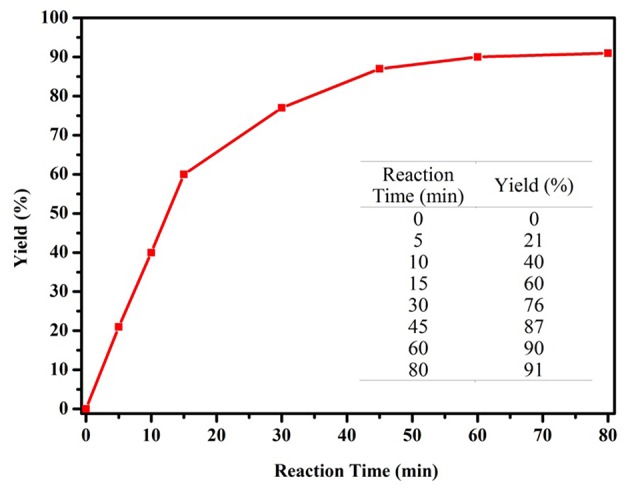
Influence of the reaction time on catalytic performance of complex 1a (1-phenylethanol 1.0 mmol, complex 1a 0.5 mol%, TBHP 2.5 mmol, CH3CN 2.0 mL).